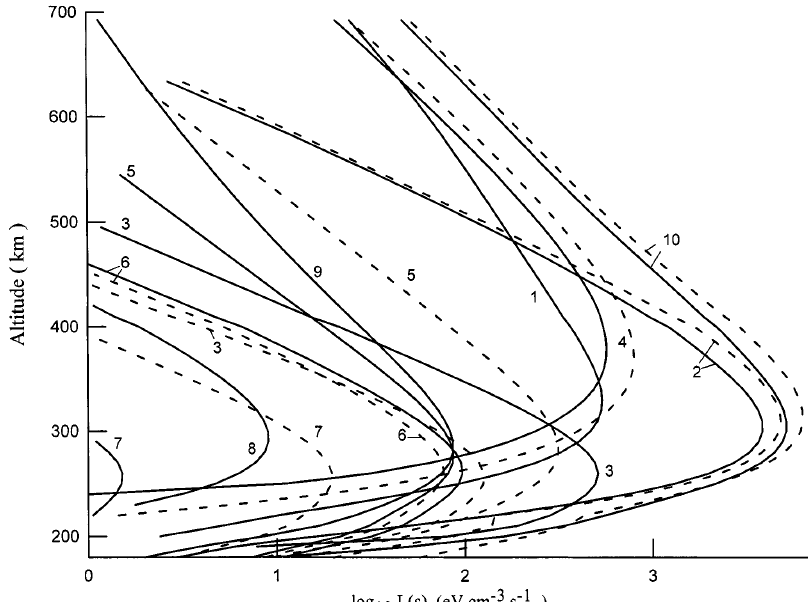
Fig. 7 that the IZMIRAN model value of L (cid:133) O (cid:133) 1 D (cid:134)(cid:134) (solid line 4) is lower than those of Stubbe and Varnum (1972) (dashed line 4) by a factor of 1.2–2.6 in the height range (cid:133) v (cid:134)(cid:134) 260–600 km. The ratio of the IZMIRAN model L (cid:133) O 2 (solid line 3) to L (cid:133) O (cid:133) v (cid:134)(cid:134) given by Prasad and Furman 2